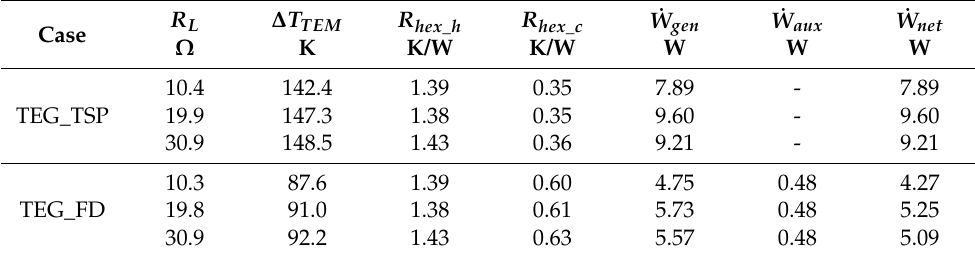
Figure 12. Net power output of both thermoelectric generators as a function of the load resistance. Table 2. Experimental results of the thermoelectric generators for an inlet temperature of t in g = 405°C, a mass flow of ˙ m g = 70kg/h, and a voltage of the fan of